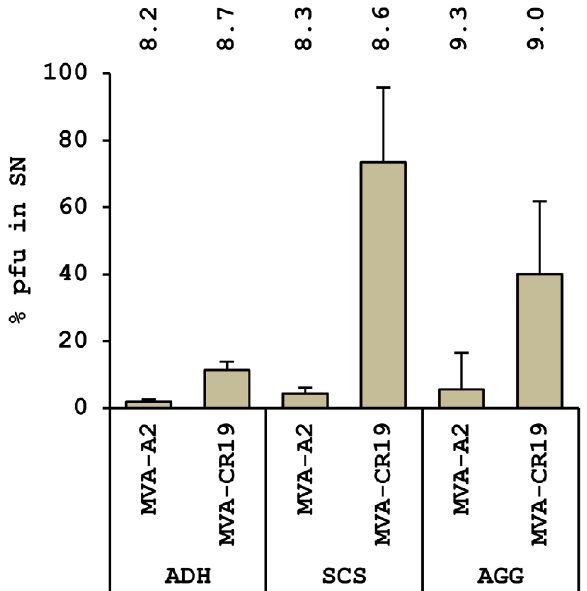
Figure 4. A higher percentage of infectious units is observed in the cell-free supernatant (SN) in cultures infected with MVA-CR19. MVA-A2: wildtype MVA; ADH: adherent CR.pIX culture maintained in DMEM:F12 medium containing 5% bovine serum; SCS: single-cell culture in CD-U3 medium; AGG: aggregate suspension culture in CD-U3 and CD-VP4 media. Number on top of the column gives log pfu/mL in the complete lysate. Error bars give standard deviation obtained in three